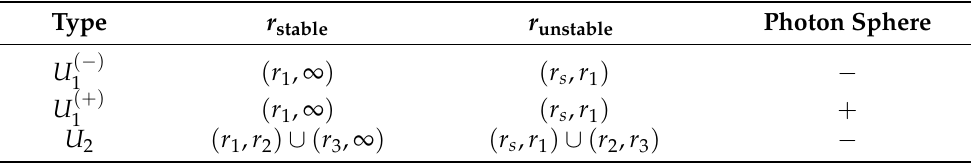
Table 1. Possible types of